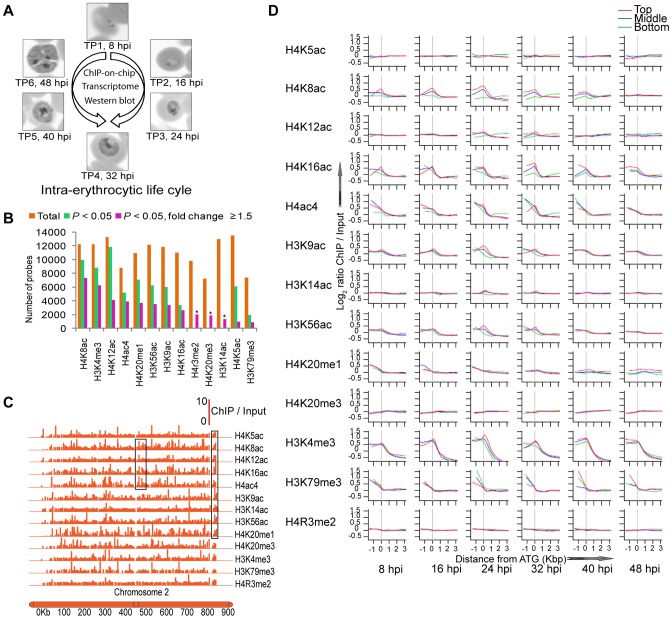
Overview of modified histones occupancy during the P. falciparum IDC.(A) Schematics of the work flow. P. falciparum cells were harvested at 8, 16, 24, 32, 40 and 48 hpi corresponding to time points TP1, TP2, TP3, TP4, TP5 and TP6, respectively, during the 48 h IDC. The same cells were used to carry out all experiments including ChIP-on-chip, transcriptome analysis and western blot assays. (B) The summary of the occupancy of 13 histone marks in the P. falciparum genome. The bar graph depicts a total count of microarray probes with positive ChIP signal which corresponds to an association of the genetic loci with the histone marks. For this analysis, only probes with a positive signal for at least 2 consecutive time points (out of 6) were considered. The graph includes the total count of genetic loci (represented by microarray probes) associated with each histone mark (orange bars), only loci with an oscillating occupancy profile (log2 ChIP/input) across the IDC defined by P<0.05 (green bars), and dynamic occupancy profile across the IDC defined by P<0.05 and ≥1.5 fold change (purple bars). The latter are referred to as “dynamic histone marks” and “dynamic occupancy profiles” in the text. Due to the lack of triplicates (scarcity of ChIP material) and consequent inability to calculate P values, only the ≥1.5 fold change criteria was applied to the dynamic occupancy profiles of H3K14ac, H4K20me3 and H4R3me2, (marked by an asterisk). The total count of microarray probes is 14,773. (C) Chromosomal projection of histone occupancy for chromosome 2 at TP2. Position and height of each vertical line reflect the location on the chromosome and ChIP/input ratio, respectively, of the corresponding probe. Black rectangles highlight apparently similar patterns between different histone marks. (D) Enrichment of histone modifications along P. falciparum genes. The graphs represent ChIP signal (see Materials and Methods) plotted along P falciparum genes against the probe position relative to translation start codon (ATG) starting −1000 bp (upstream) to +3000 bp (within the ORF) (note that transcriptional start sites remain largely unmapped in P. falciparum). For each of the 6 time points across the IDC, the lowess smoothed profiles of the ChIP signal is plotted for three gene groups including 10% of total genes at the top (Top), in the middle (Middle) and at the bottom (Bottom) of the gene list ranked by their mRNA levels at the particular time point. The vertical line in grey indicates the position of the ATG. For these graphs, all histone-mark-occupancy results were used, including both the constitutive and dynamic occupancy profiles.